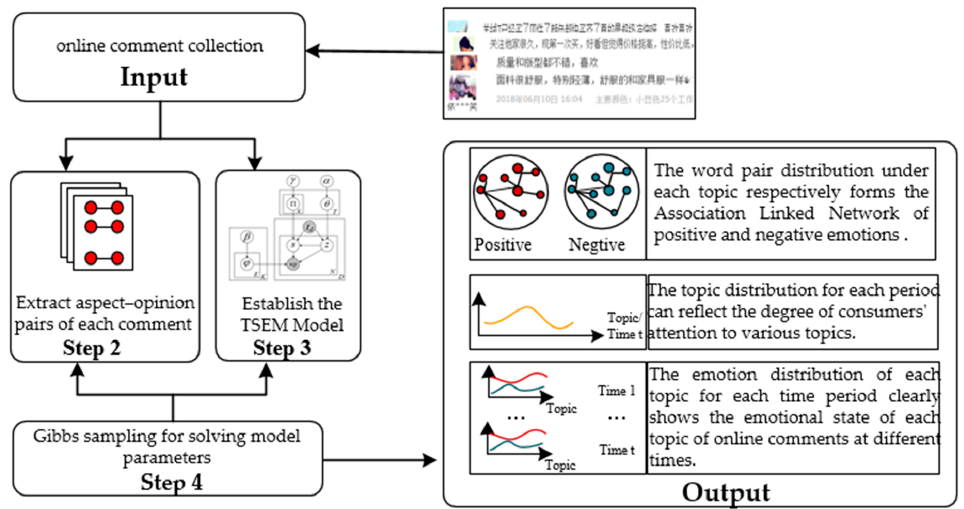
Figure 2. The overall framework of emotion mining for online comments.